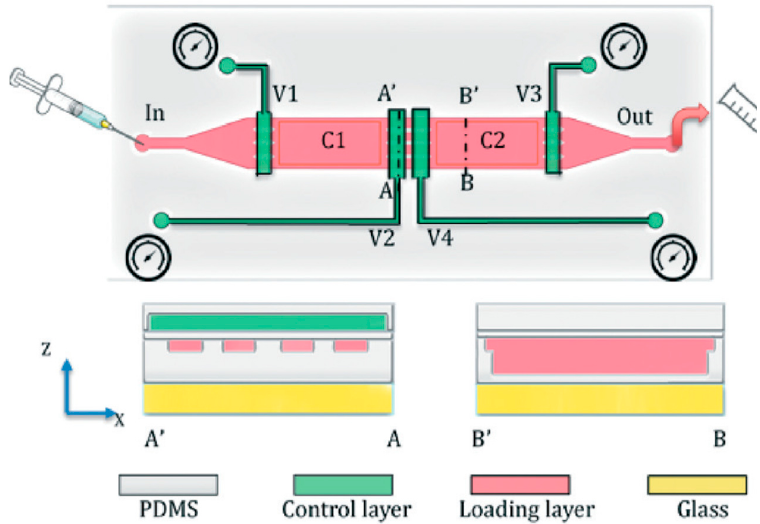
Figure 11. Schematic representation of the microfluidic device developed by Dong et al. [71] illustrating the two layers in the chip (control layer and flow layer) and their different parts. Reprinted with permission from the Royal Society of Chemistry.